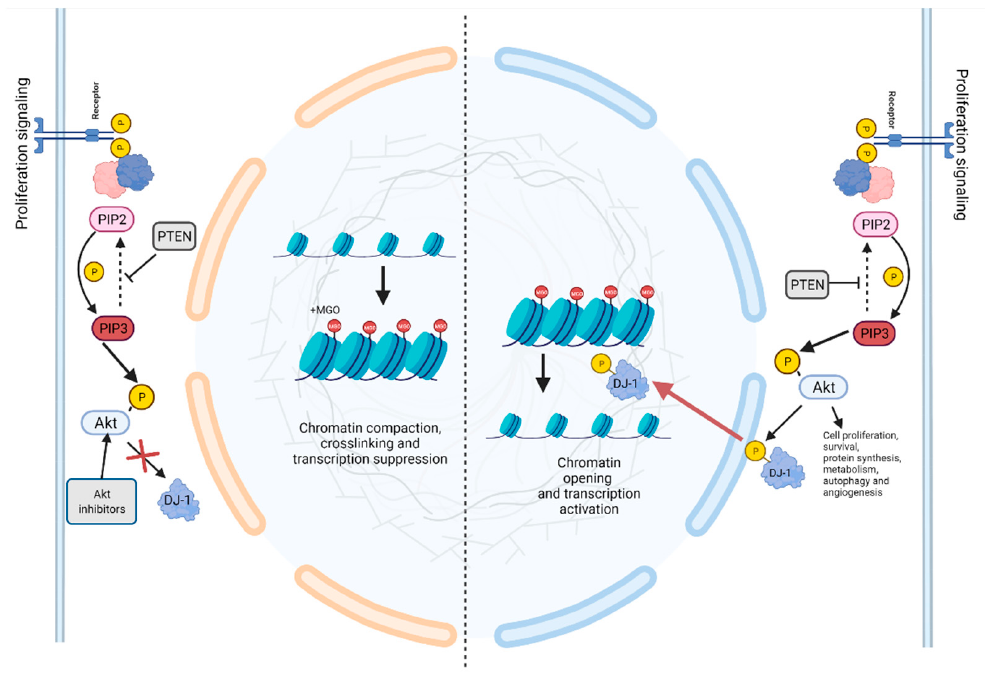
Figure 2. Role of DJ-1 during dicarbonyl stress. In senescent cells, the hyper-glycolitic phenotype induces dicarbonyl stress. Left side: In cells treated with Akt inhibitor, DJ-1 does not undergo phosphorylation. Unphosphorylated DJ-1 loses its glyoxalase activity and is unable to counteract the formation of MGO adducts, accounting for chromatin destructuration. Right side: In proliferating cell, under the activation of the Akt pathway, DJ-1 undergoes phosphorylation and translocates into the nucleus where it acts as glyoxalase. This activity preserves the histones code and the malignant proliferative potential.